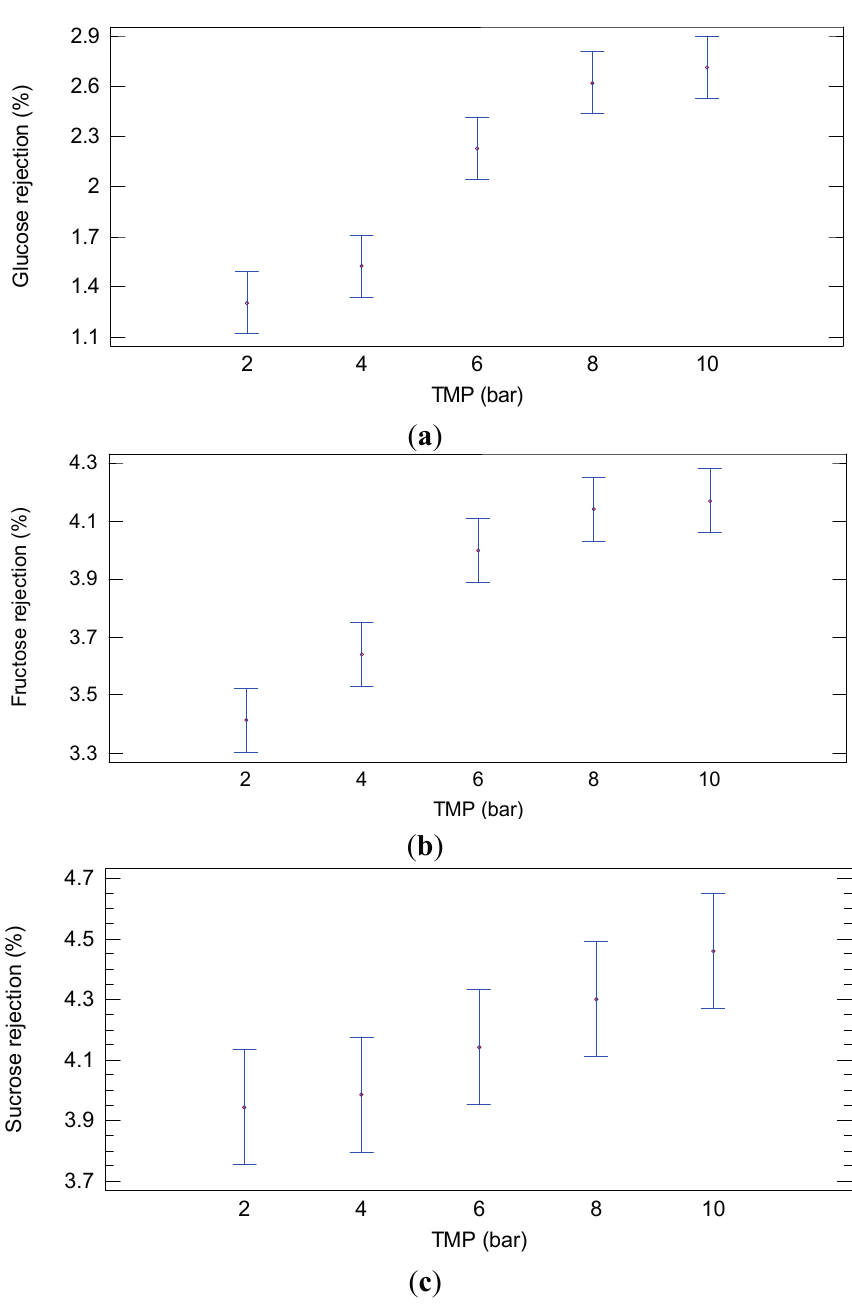
Figure 2. Least significant difference (LSD) plot showing the effect of TMP on the rejection of ( a ) glucose ( b ) fructose and ( c ) sucrose (NP030 membrane, total recycle configuration, 25